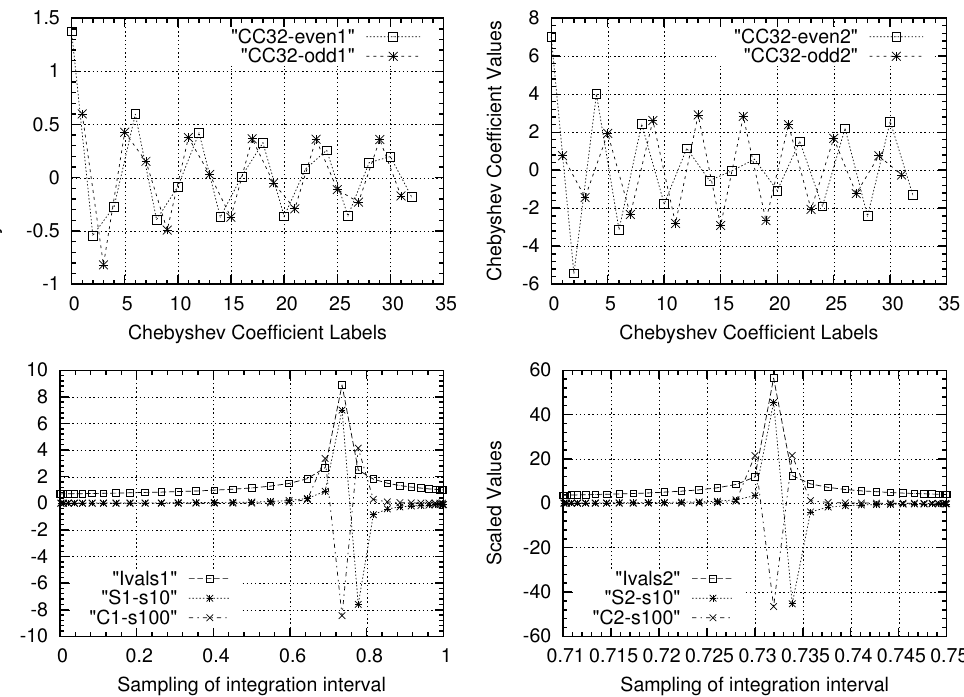
Figure 1. (Top) For Case Study 1, CC-32 rule yields Chebyshev expansion coe ffi cients showing irregular be- haviour: left – on [0 , 1], right – on [0 . 71 , 0 . 75]. (Bottom) Scrutiny of the three basic elements of the Simpson rules (Ivalsk: Integrand values k , Sk-s10: Slopes k , scaled by a factor 10 − 1 ; Ck-s100: Curvatures k , scaled by a factor 10 − 2 ) results in Bayesian inference of integrand singularity ( k = 1; left) which is confirmed under iteration on the smaller interval ( k = 2;